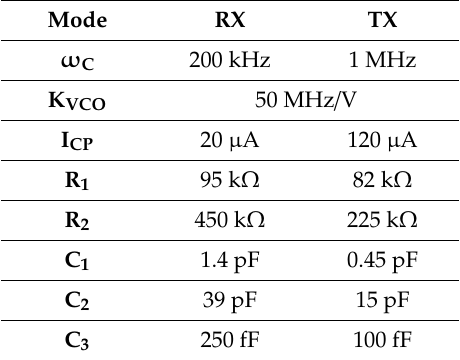
Table 1. Parameter of loop filter in